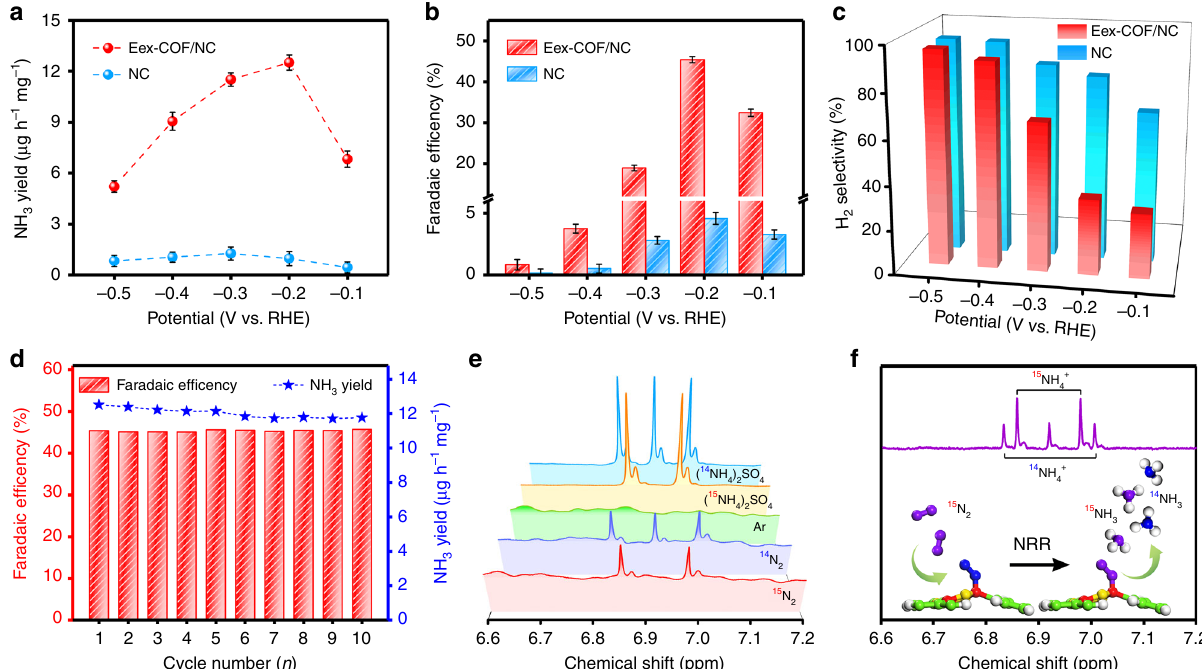
Fig. 4 Electroreduction of N 2 to NH 3 at ambient conditions. a NH 3 yield rates, b corresponding Faradaic ef fi ciencies, and c H 2 selectivity of Eex-COF/NC and NC. The error bars correspond to the standard deviations of measurements over three separately prepared samples under the same conditions. d The NH 3 production performance in durability test of Eex-COF/NC. e 1 H nuclear magnetic resonance (NMR) spectra of the NRR products using the same isotope feeding gas for excitation and NRR. f 1 H NMR spectrum of the NRR products using 14 N 2 for excitation and 15 N 2 for NRR. The red, green, blue, purple, yellow, and gray spheres represent B, C, 14 N, 15 N, O, and H atoms,